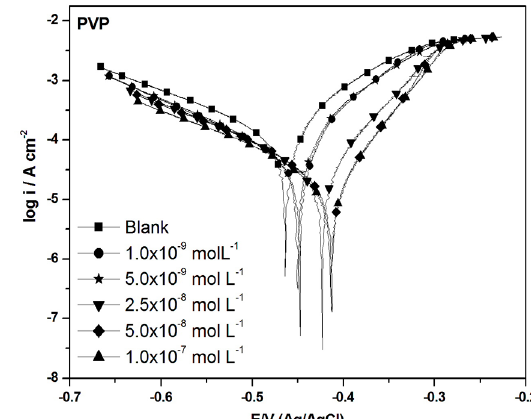
Figure 3. Polarization curves of carbon steel in 0.5 mol L -1 HCl in the presence and absence of PVP.